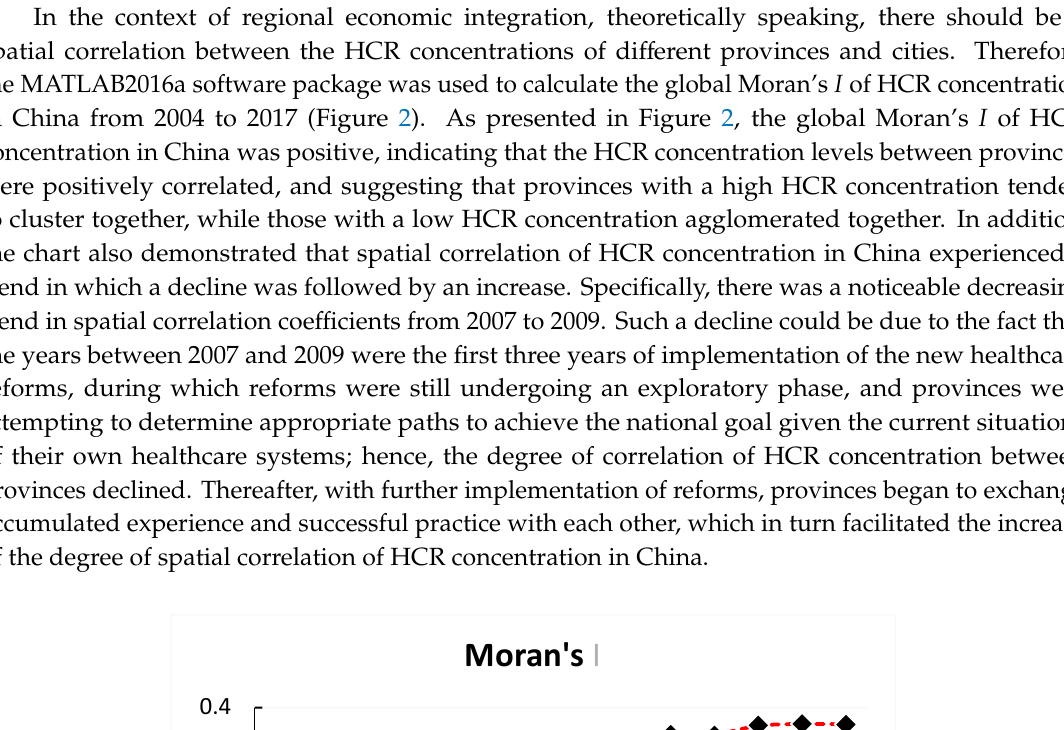
Table 4 . Results of the Spatial Econometric Model Test